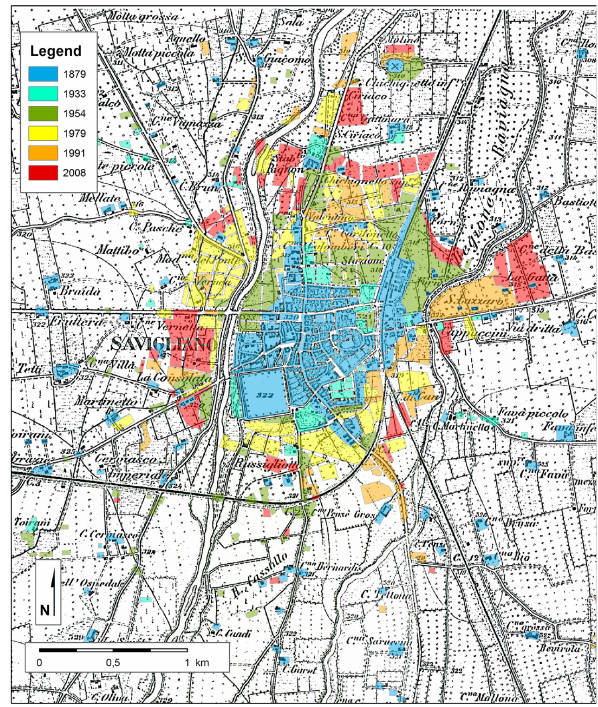
Fig. 5. The built-up area increases since 1879 (editing and area cal- culation were done with GIS). The Maira and Grana-Mellea streams are on left and right side, respectively, in the picture. Background: the Army National Geographic Institute (IGMI) map, 1879